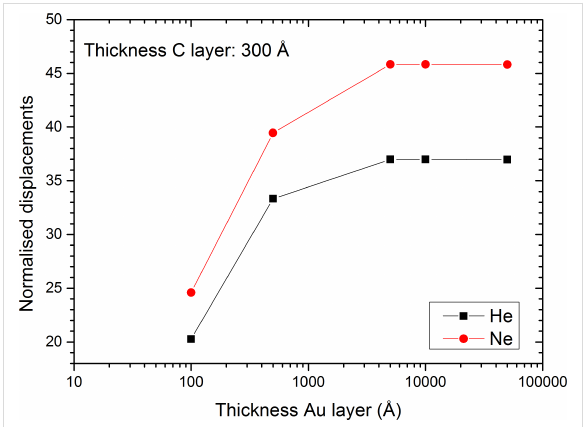
Figure 7: Displacements into the carbon layer normalised to incident ion as a function of gold thickness for He and Ne irradiation of a 30 nm carbon film deposited onto a gold grid. Results were obtained by